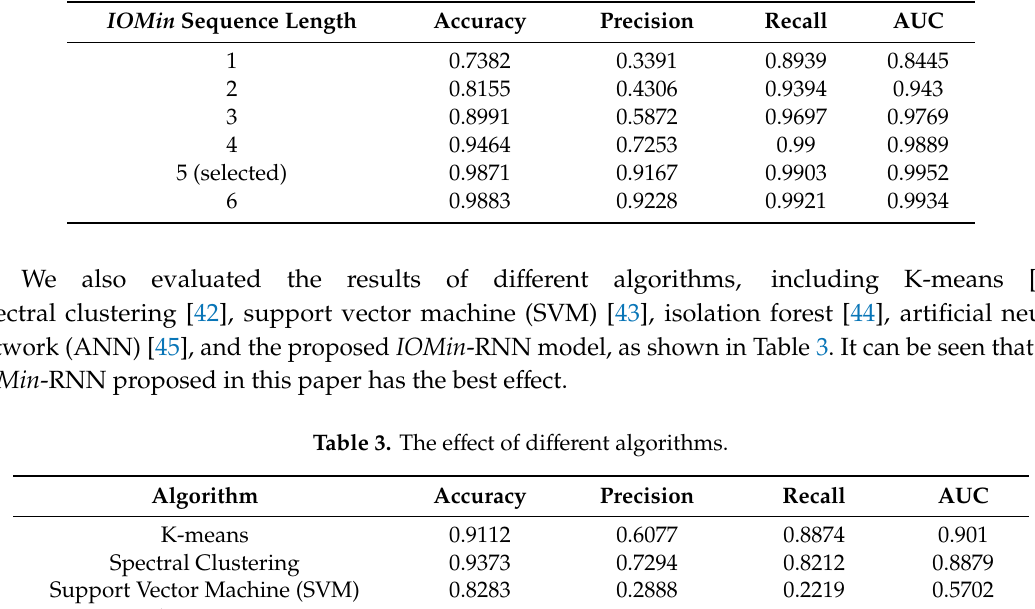
Table 2. The e ff ect of di ff erent IOMin sequence length on road user detection.